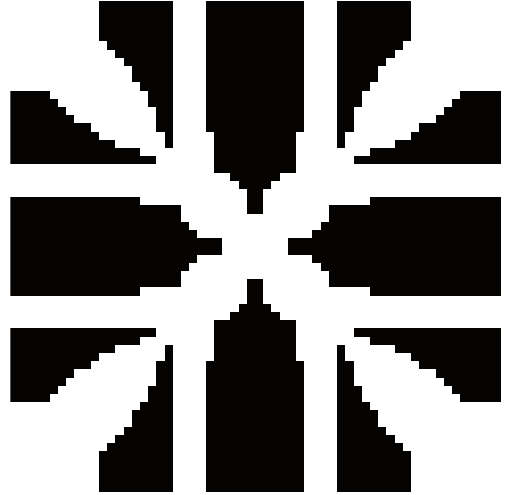
Fig. 2. Temperature distribution when high conductive material is uniformally distributed.